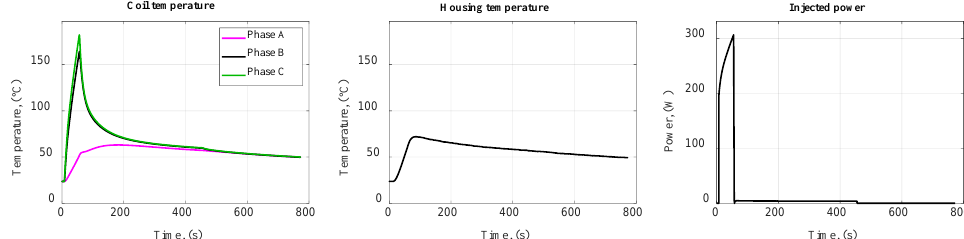
Figure 5. Measured temperatures for the pulse test with the highest injected current value in configuration A.